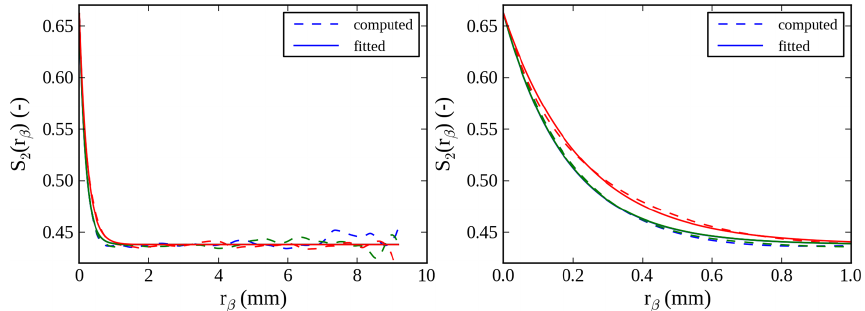
Figure 3. Two-point probability function S 2 ( r ) for the whole range of r (left panel) and magnified (right panel) in the x (blue), y (green) and z directions (red), obtained from the 3-D image referred to as 7G in Table 1. Solid and dashed lines correspond, respectively, to the values computed from Eq. (3) and to the results of the expression S 2 (r β ) = ( φ − φ 2 ) exp ( − r β /l c